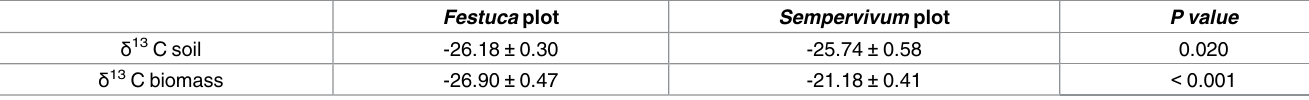
Table 1. Comparison of isotopic ratio of carbon in the vegetation communities.